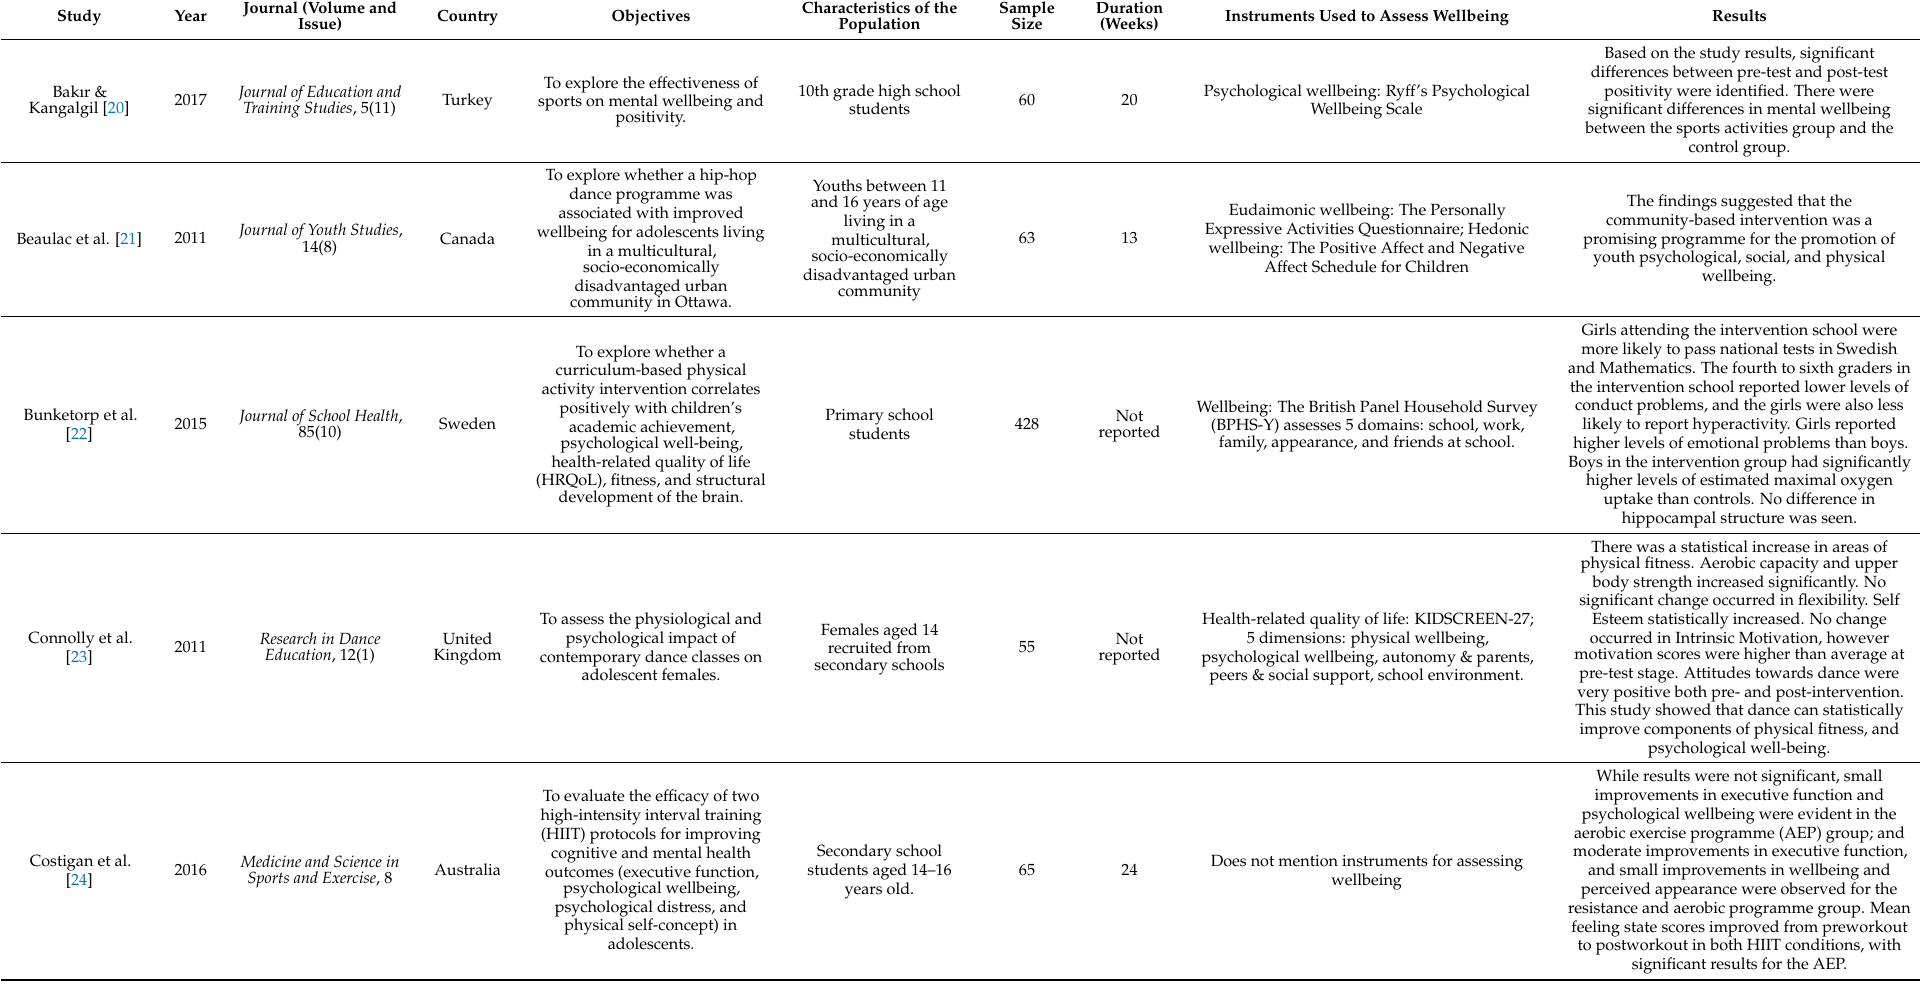
Table 1. General overview of the articles